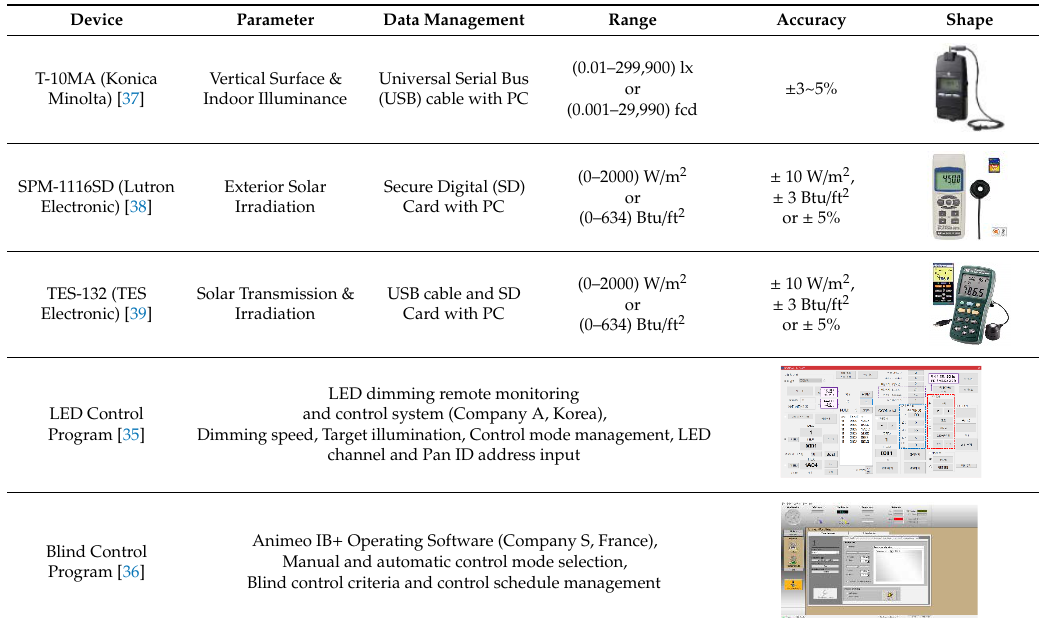
Table 3. Measured parameters and sensor specifications [35–39].